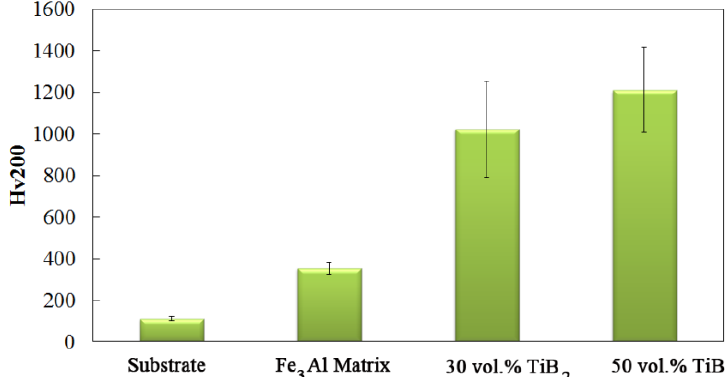
Figure 4. Hardness of the substrate and coatings as a function of different TiB 2 content.